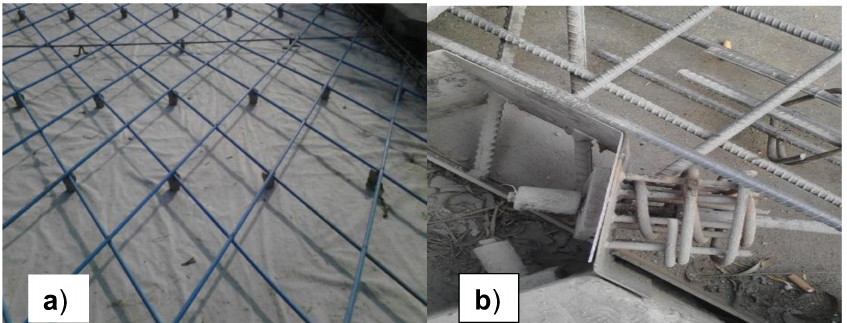
Figure 9. ( a ) The distribution of the prestressed tendons; and ( b ) the fixed end